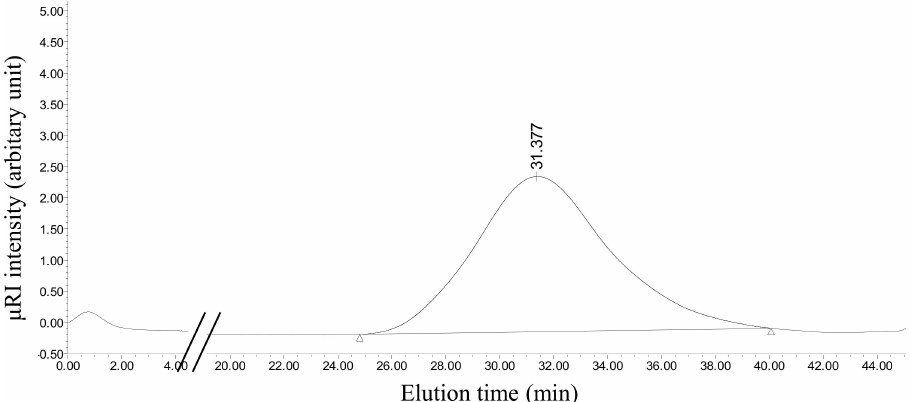
Figure 4. Elution pattern of the processed DhPs in 0.05 M NaCl solution at 40 ◦ C using HPGPC.